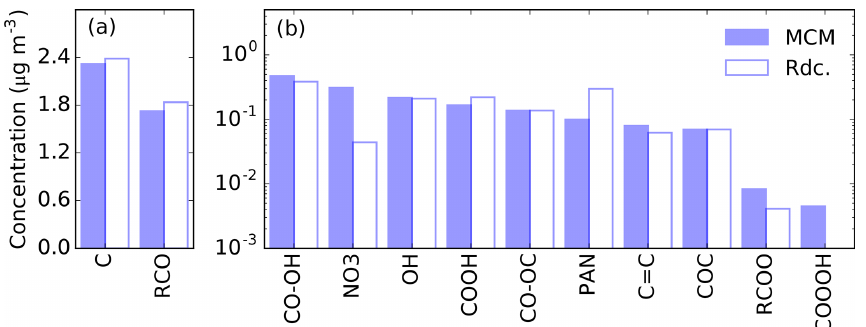
Figure 9. Average SOA mass per functional group simulated with the pre-testing dataset using the MCM (blue bar) and Rdc. mechanisms (white bar) at 72h. The figure is divided into two panels, (a) and (b) , due to the large gap in mass between the groups. The labels of the functional groups, from left to right, are as follows: C – carbon bond, RCO – carbonyls (ketone and aldehyde), CO–OH – hydroxy